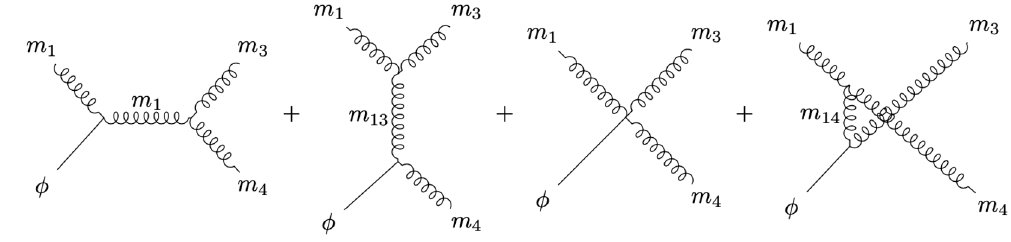
Figure 5 . Feynman diagrams showing the Aφ → AA process for m I = 0